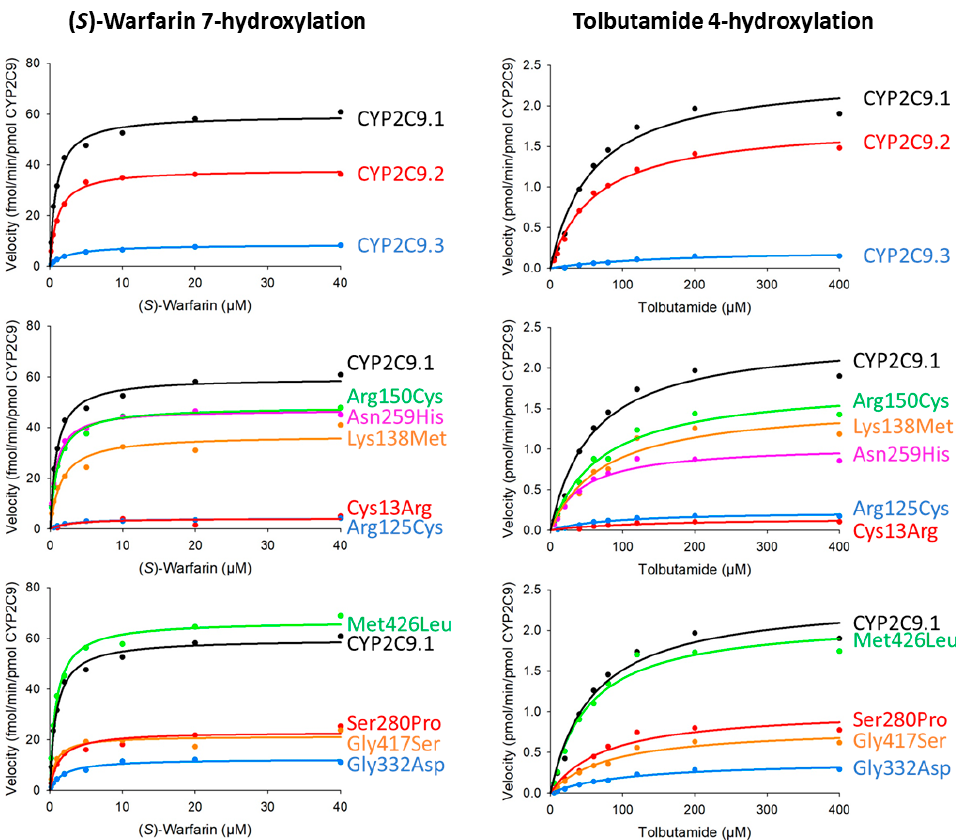
Figure 2. Michaelis-Menten curves for CYP2C9 variants. Determined kinetic parameters of ( S )-warfarin 7-hydroxylation and tolbutamide 4-hydroxylation. All assays and measurements were performed in triplicate using a single microsomal preparation.